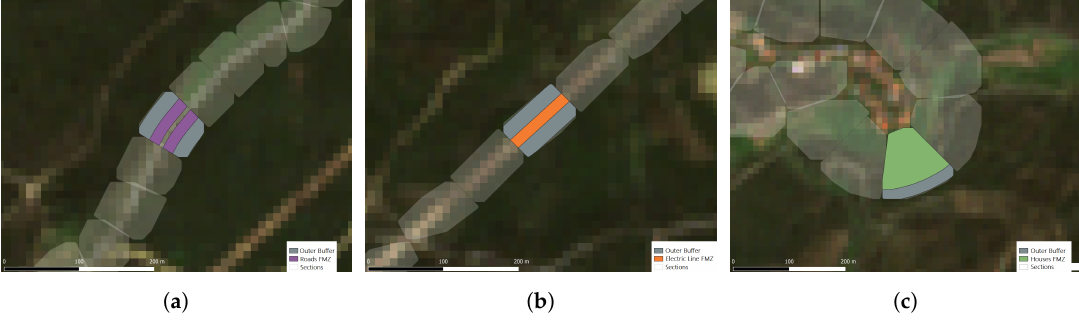
Figure 8. Examples of the intersection of Fuel Management Zones (FMZs) and buffers with the created sections. ( a ) Section of an FMZ along a road. ( b ) Section of an FMZ along an electric line. ( c ) Section of an FMZ around a cluster of